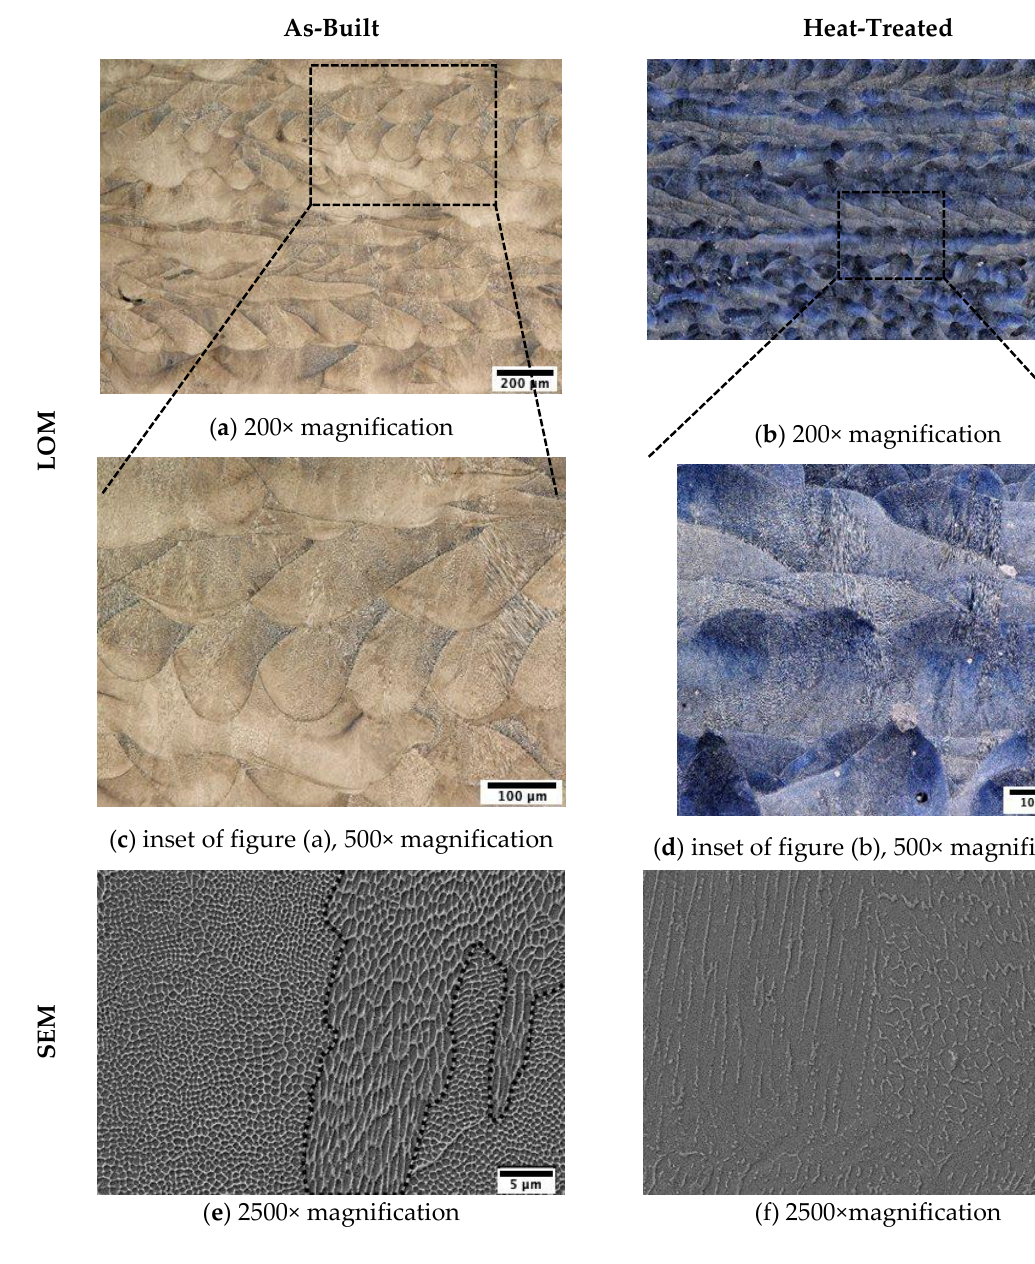
Figure 4. Light optical microscopy and scanning electron microscope images of etched L-PBF samples in the as-built and heat-treated